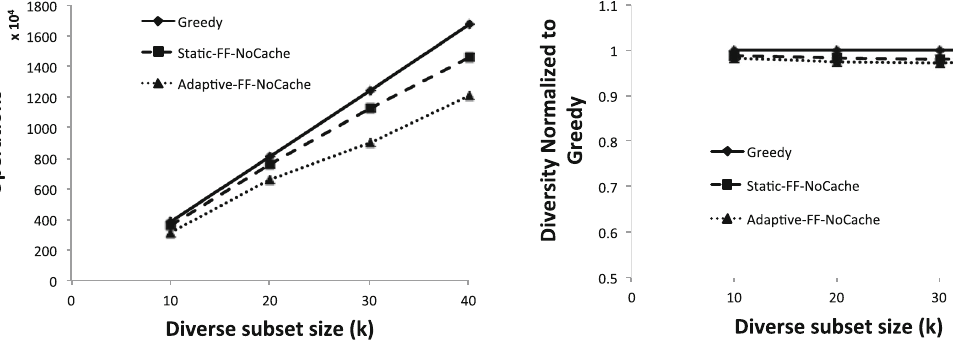
Fig. 8 Adaptive model versus